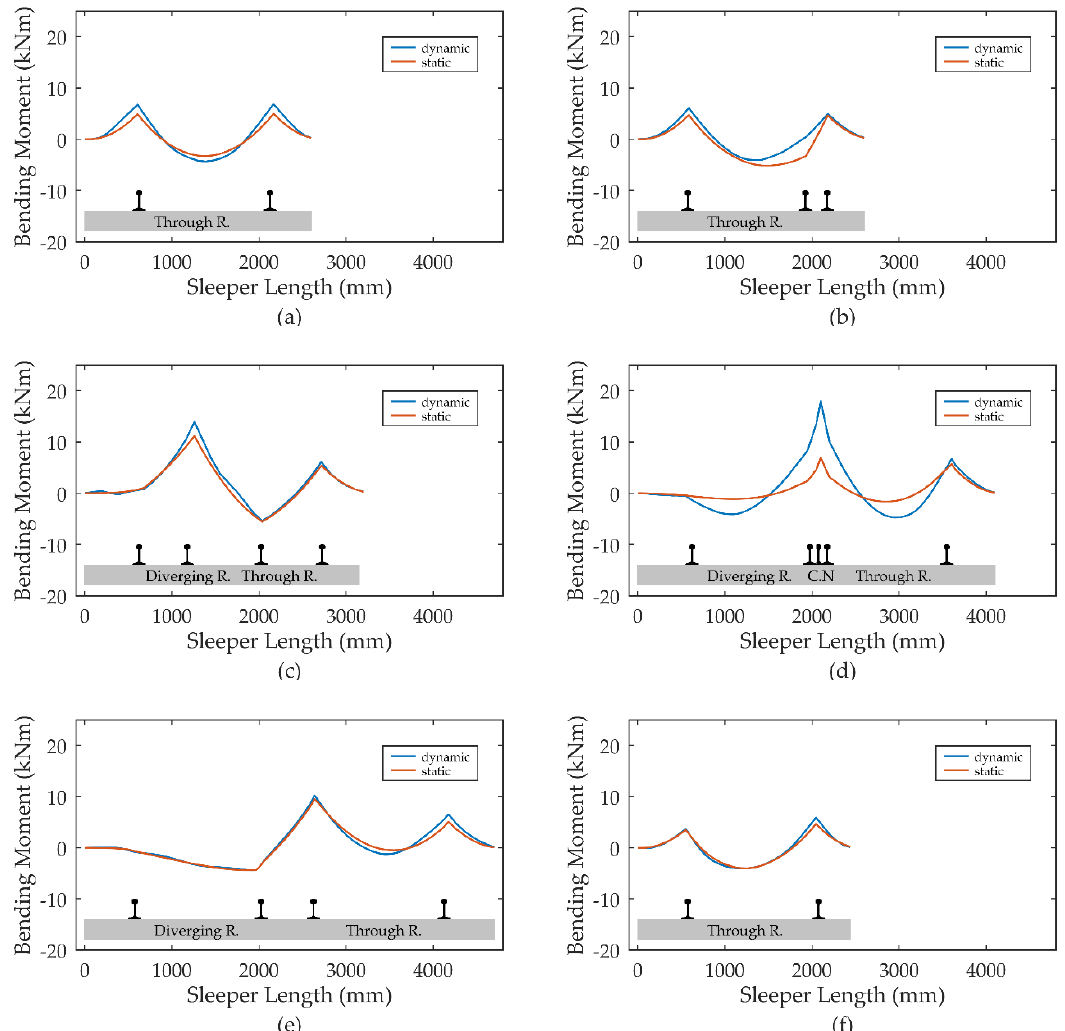
Figure 4. Flexural responses of sleepers and bearers: ( a ) Sleeper at the entrance; ( b ) sleeper under the switch blades; ( c ) sleeper at the closure panel; ( d ) sleeper under the crossing nose; ( e ) the longest sleeper; ( f ) the shortest sleeper.